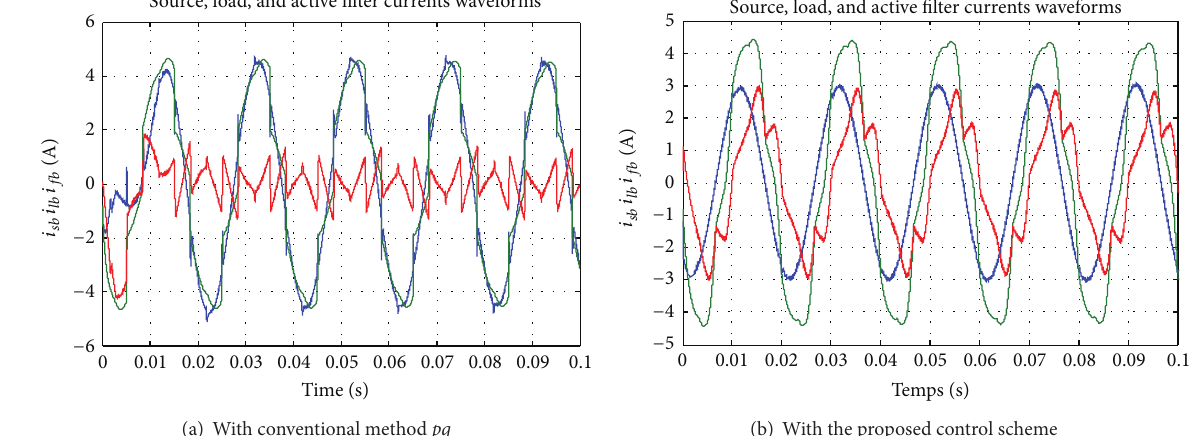
Figure 17: Source, load, and active filter currents of phase- b